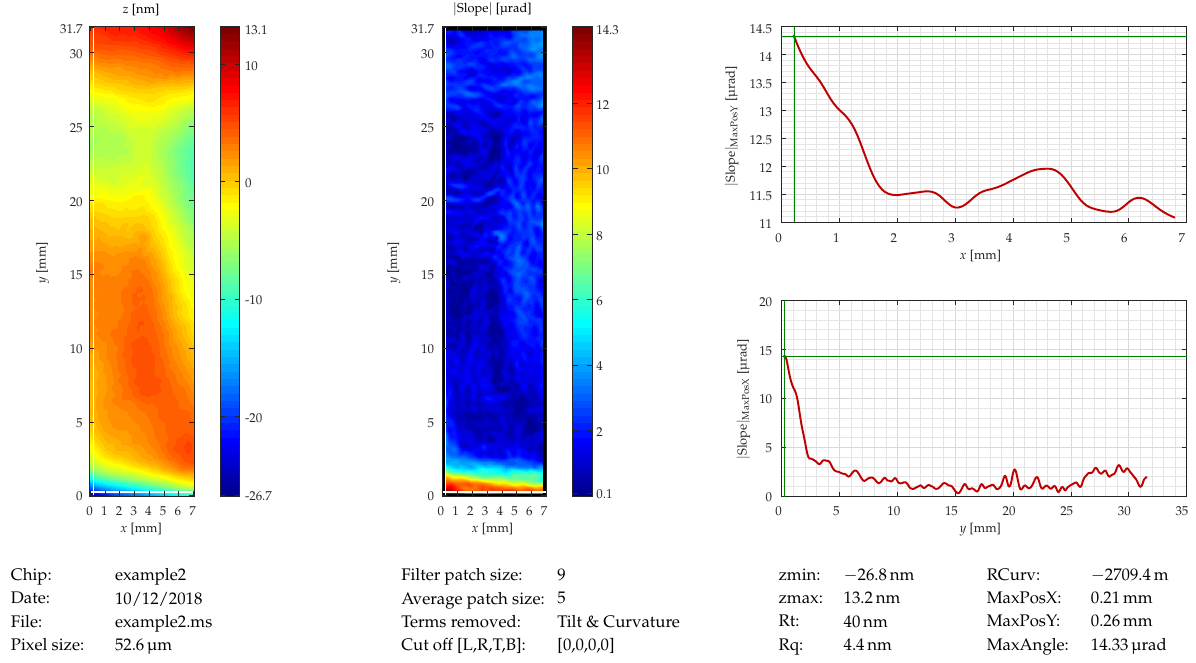
Figure 11. Global planarity: the white lines in the left image (at the left and bottom, intersecting at the point with the highest slope) indicate the position of the curves on the